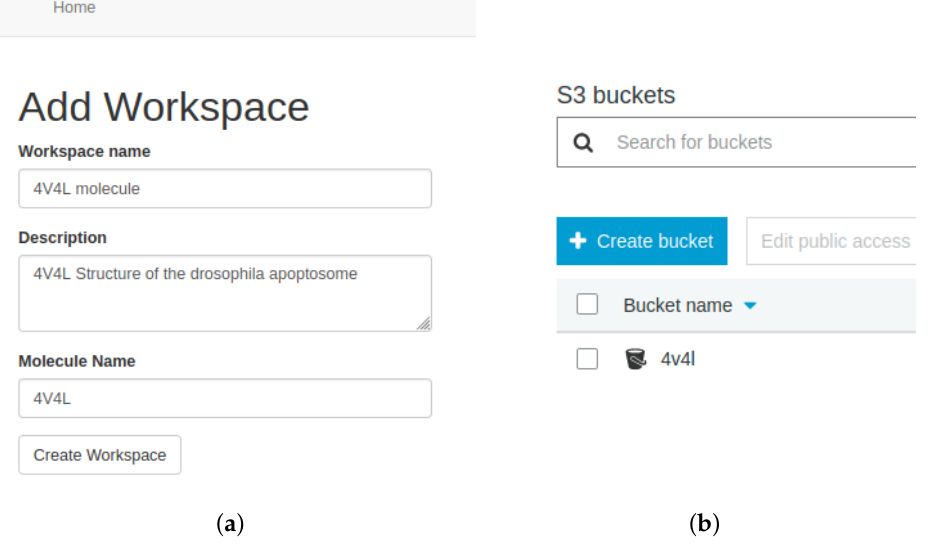
Figure 7. Creation of a workspace for a molecular system: ( a ) shows how a workspace is created in the tool; ( b ) depicts the related bucket created in the AWS S3 service.